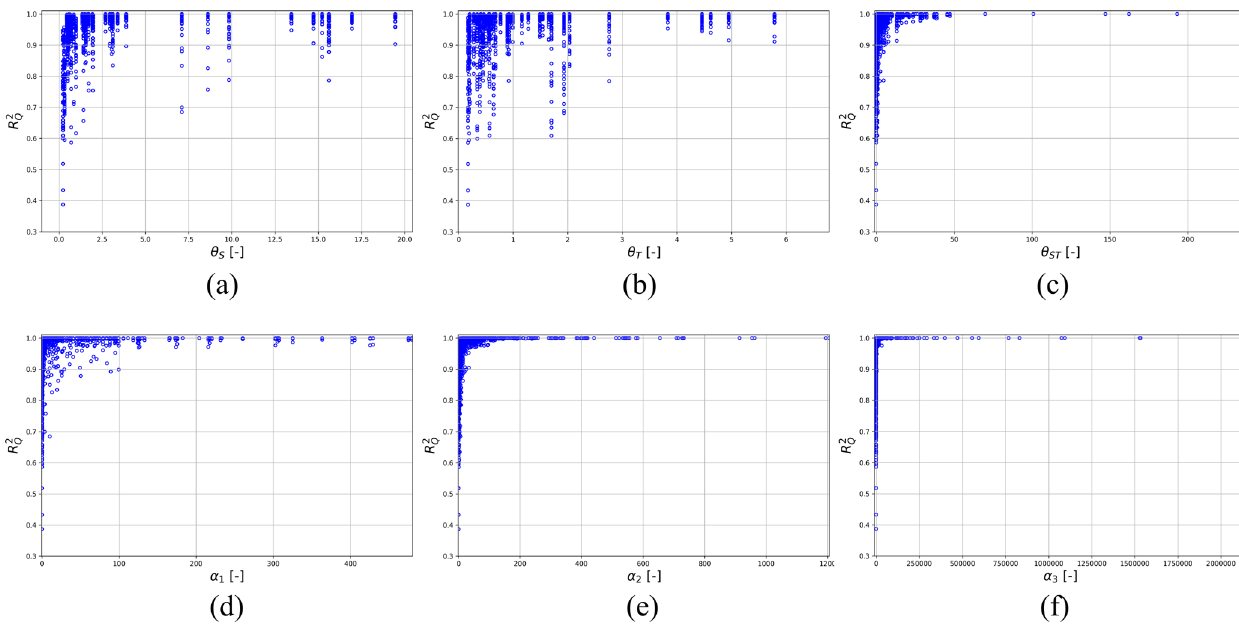
Figure 11. Performance statistic R 2 as a function of dimensionless numbers θ S , θ T , θ ST , δ S , δ T , δ ST , γ S , γ T , γ ST , α 1 , α 2 and α 3 . For each Q parameter all events, rainfall resolutions and locations are